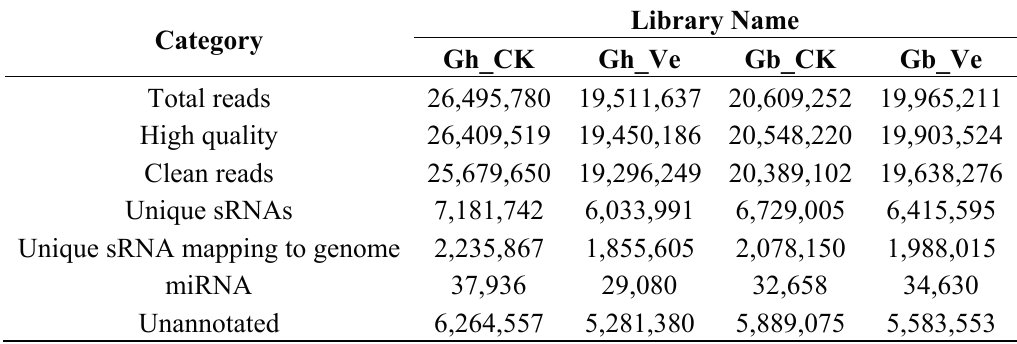
Table 1. Analysis of small RNA (sRNA) reads from four sRNA